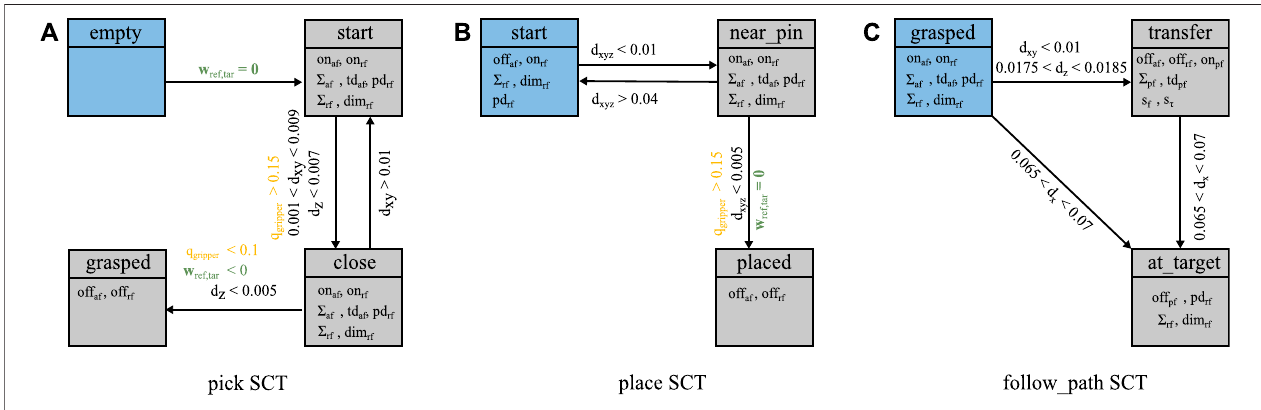
FIGURE5| States, transitions and the respective parameters describing the pick SCT (A) , the place SCT (B) ,and the follow_path SCT (C) . Theblue states indicatethestartingstatesoftherespectiveSCT.TheyellowinformationareprovidedbytheRDT,thegreenbytheODTandtheblackarecomputedasacombinationof ODT and